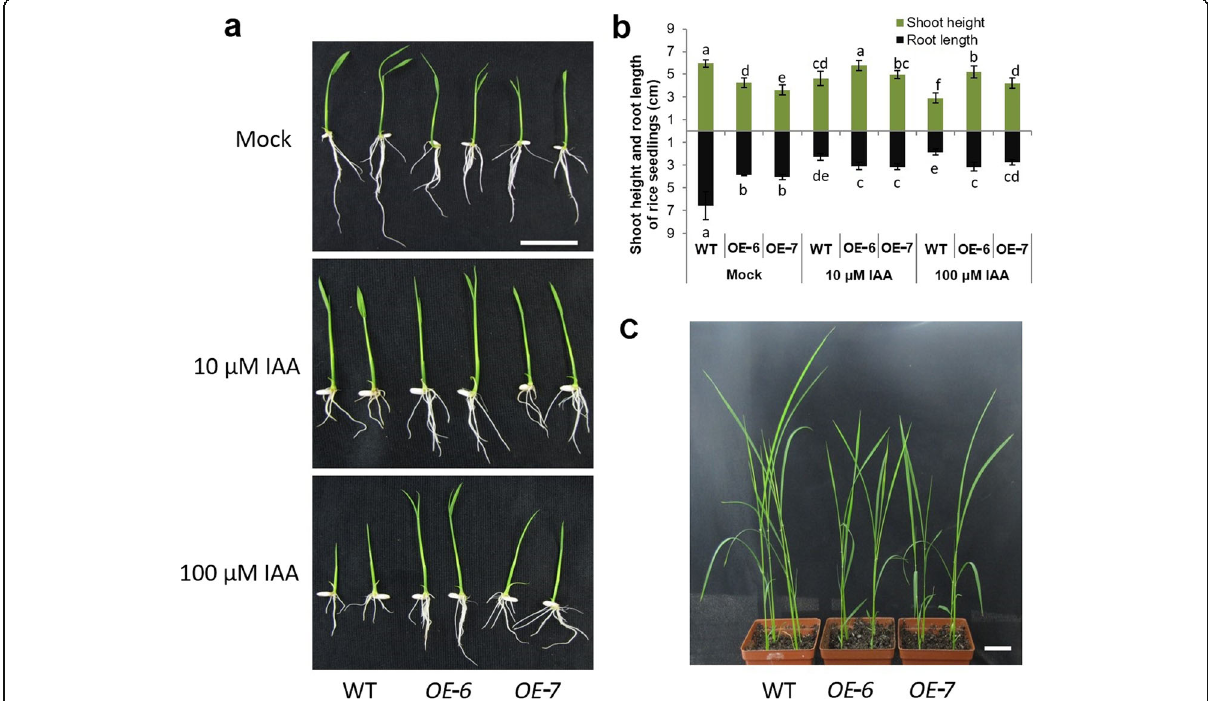
Fig. 8 Effect of OsIAGT1 overexpression on rice shoot and root growth. a 7-day-old WT, OE-6 and OE-7 rice seedlings before and after exogenous IAA treatment. Bars, 3 cm. b Statistic data of shoot height and root length of rice seedlings before and after IAA treatments. Values are means±SD ( n ≥ 9). Different lower-case letters indicate significant difference based on the Duncan ’ s multiple range test ( p < 0.05). c 3-week-old WT, OE-6 and OE-7 rice plants. Bar, 3